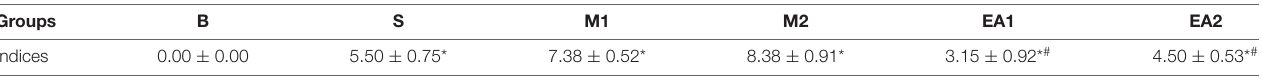
TABLE 3 | Statistical analysis of the Lequensne index of rabbit behavior in each group. Groups B